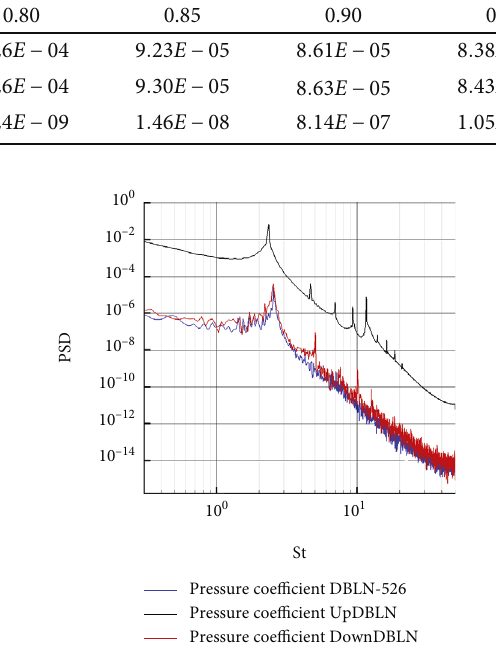
Figure 33: PSD of pressure coe ffi cient ( Re = 0 : 8 E 6 , α = 0 ° ).